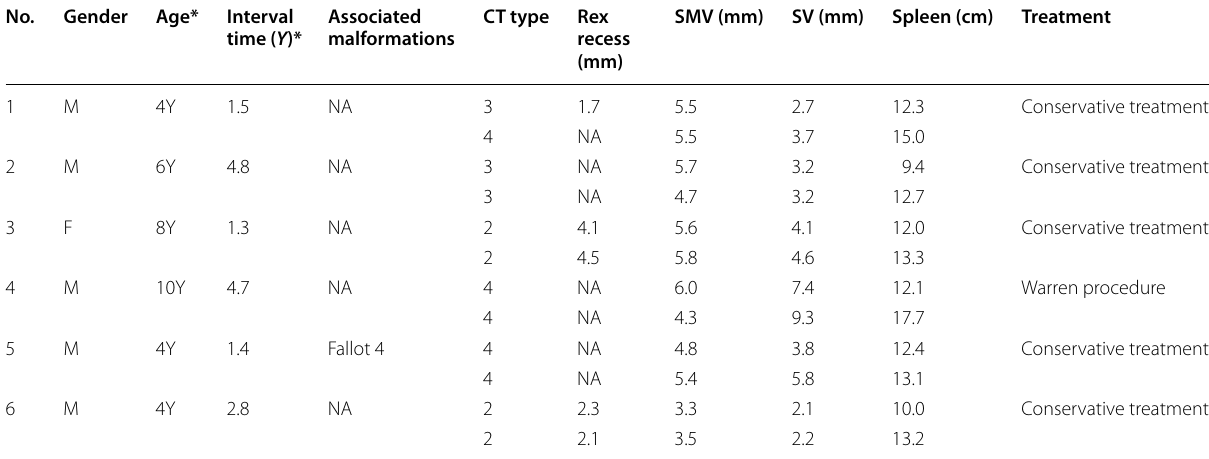
Table 4 Re-examination CT angiography before MRB in six